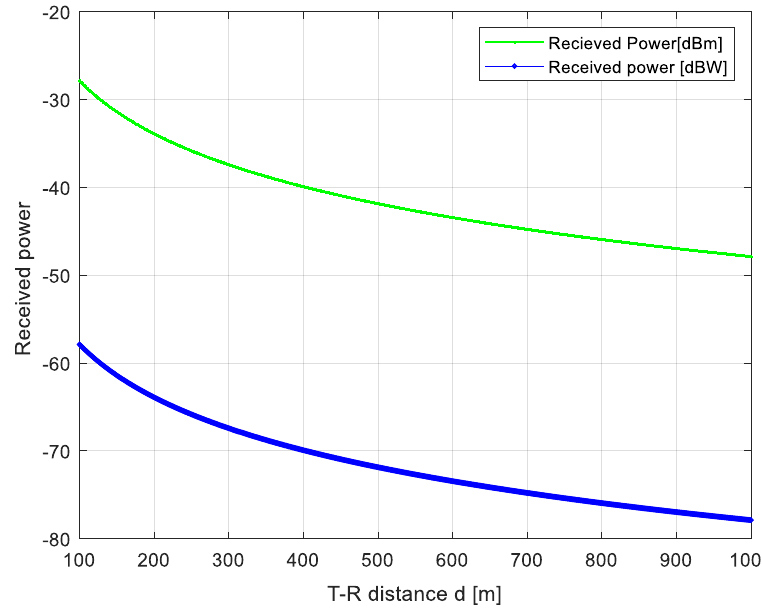
Figure 12. Attenuated signal power plot versus T-R propagation distance.